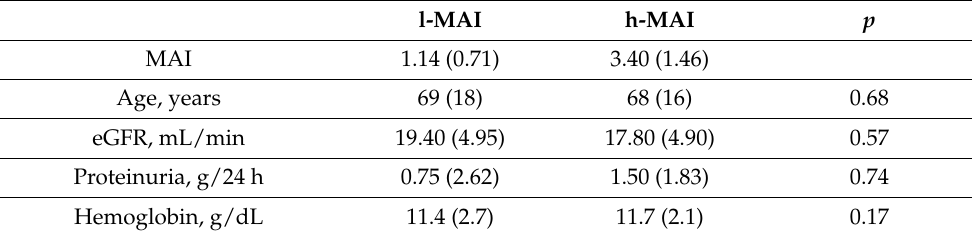
Table 3. Comparison between routine biochemical parameters, microbiota-derived toxins, and Lp-PLA 2 in low- and high-MAI